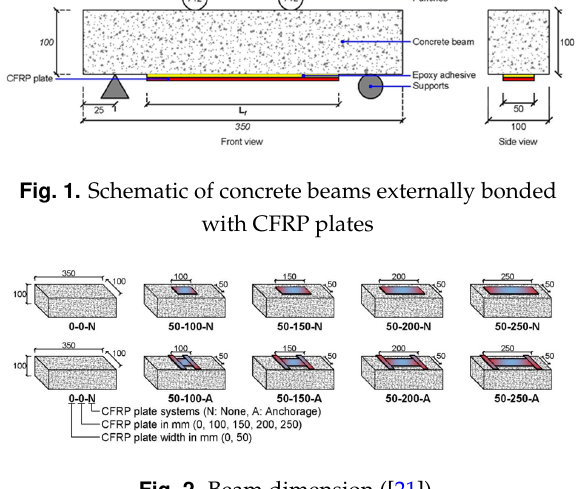
Fig. 2. Beam dimension